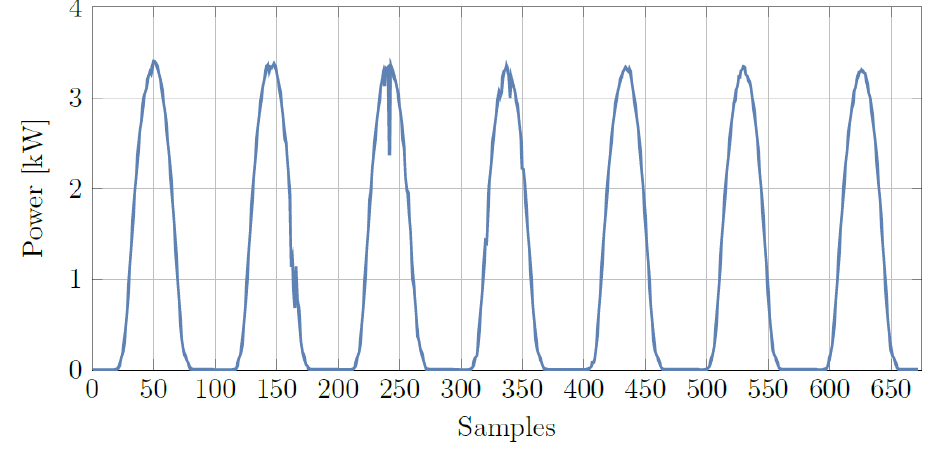
Figure 6. Trends of produced power referred to summer period from 15 July 2020 to 21 July 2020. Days are regular and the power profiles have a well recognizable